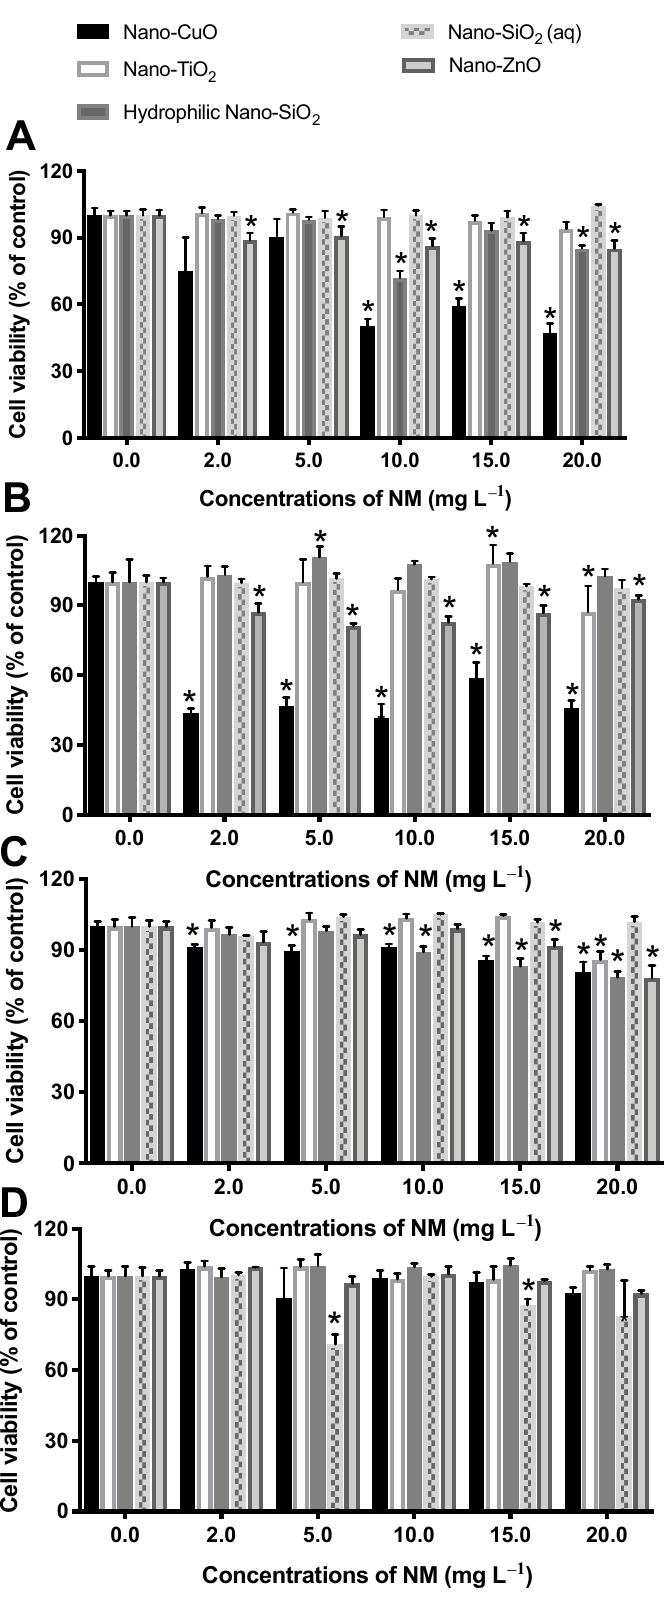
Figure 5. Cell viability of Caco-2 ( A ), HepG2 ( B ), SV-80 ( C ) and HaCaT ( D ) cells, after 48 h exposure to different NMs, as denoted, at concentrations ranging from 2 to 20 mg L − 1 . Results are expressed as the percentage of control, and for each cell line, each concentration was tested in quadruplicate. Control group corresponds to non-exposed cells, set as 100% of cell viability. Significant differences in cell viability compared to the control group are indicated by * p < 0.05 (ANOVA followed by Dunnett’s